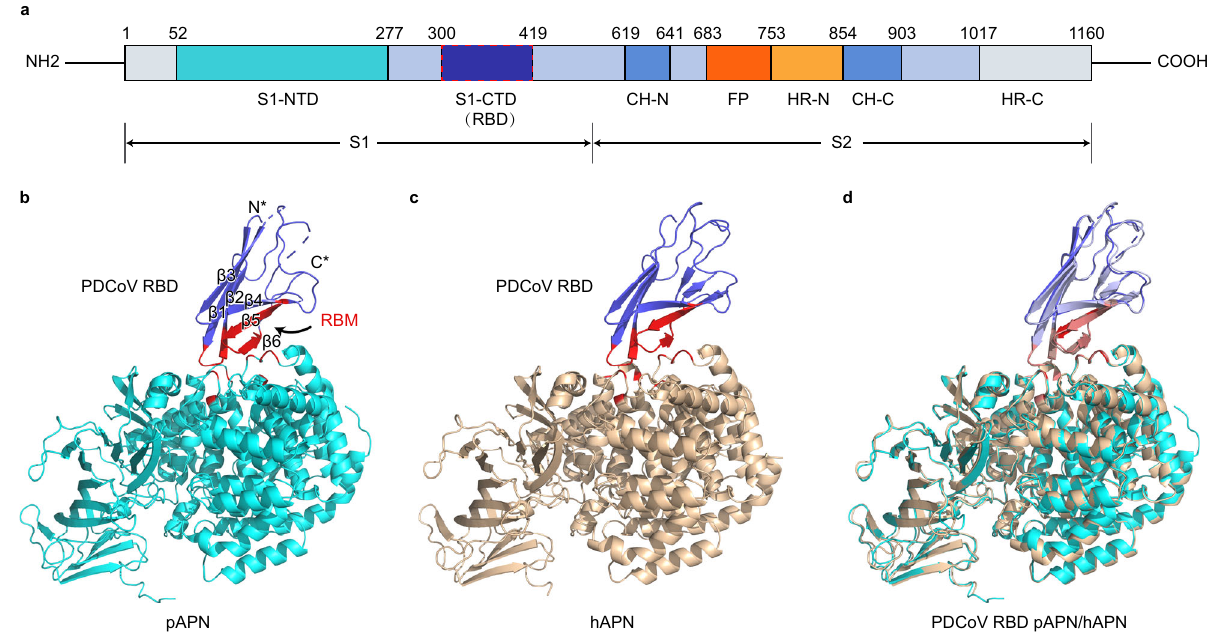
Fig. 1 Overall structure of PDCoV RBD in complex with human APN (hAPN) or porcine APN (pAPN). a Schematic diagram of the PDCoV spike (S) protein ectodomain. S1-NTD, N-terminal domain of S1. S1-CTD, C-terminal domain of S1. RBD receptor binding domain. CH-N N-terminal central helix. CH-C C-terminal central helix, FP fusion peptide, HR-N N-terminal heptad repeat, HR-C C-terminal heptad repeat. b Crystal structure of PDCoV RBD bound to pAPN. PDCoV RBD and pAPN are colored in purple and cyan, respectively. The receptor-binding motifs (RBMs) on PDCoV RBD and virus binding motifs (VBMs) on pAPN are shown in red. PDCoV RBD adopts β barrel structure and contains six β -strands. c Crystal structure of PDCoV RBD bound to hAPN. PDCoV RBD and hAPN are colored in purple and brown, respectively. RBMs and VBMs are represented as in ( b ). d Superposition of PDCoV RBD – pAPN and PDCoV RBD – hAPN complexes. The two structures exhibit high similarity and the root mean square deviation (RMSD) between them is 0.63